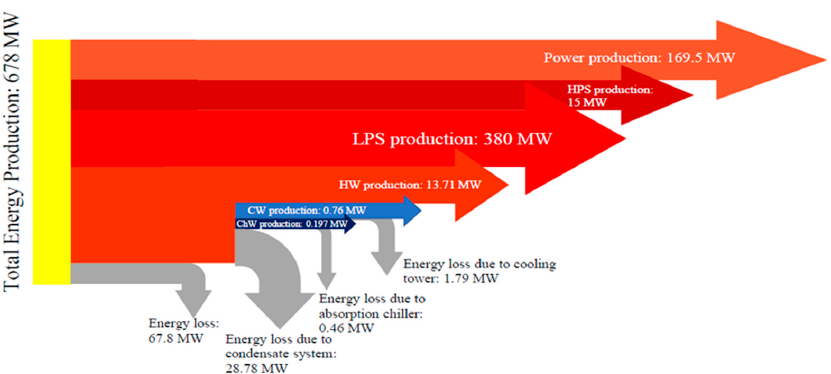
Figure 6. Energy balance for a trigeneration system.